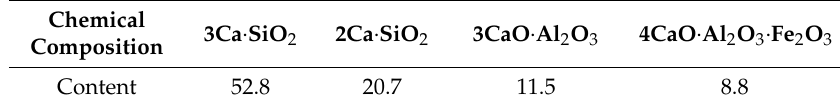
Table 1. Chemical composition of portland cement.